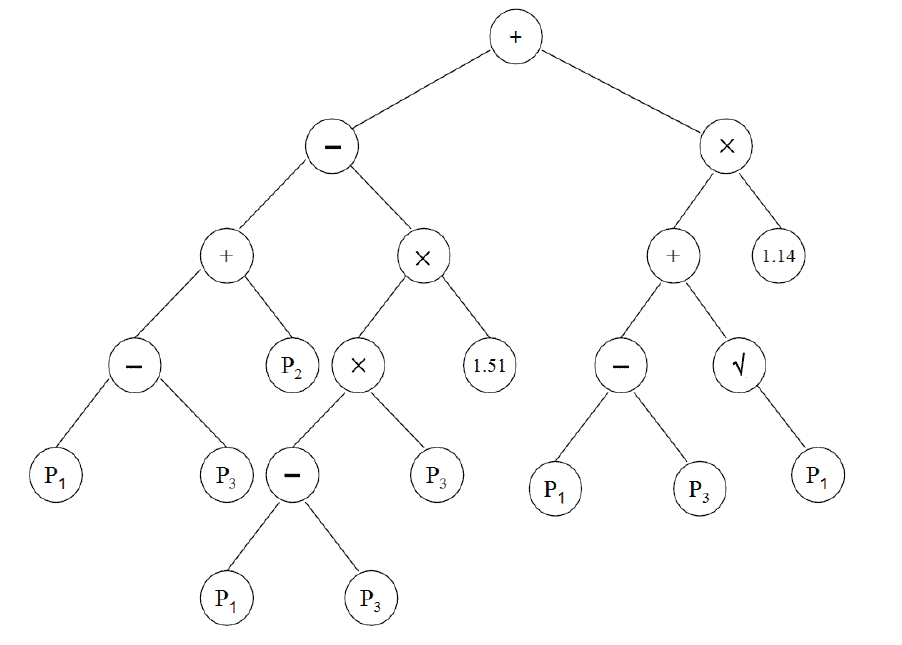
Figure 5. The tree structure representations of symbolic expressions produced by GP for the downscaling of rainy days at Besut (descriptions of P